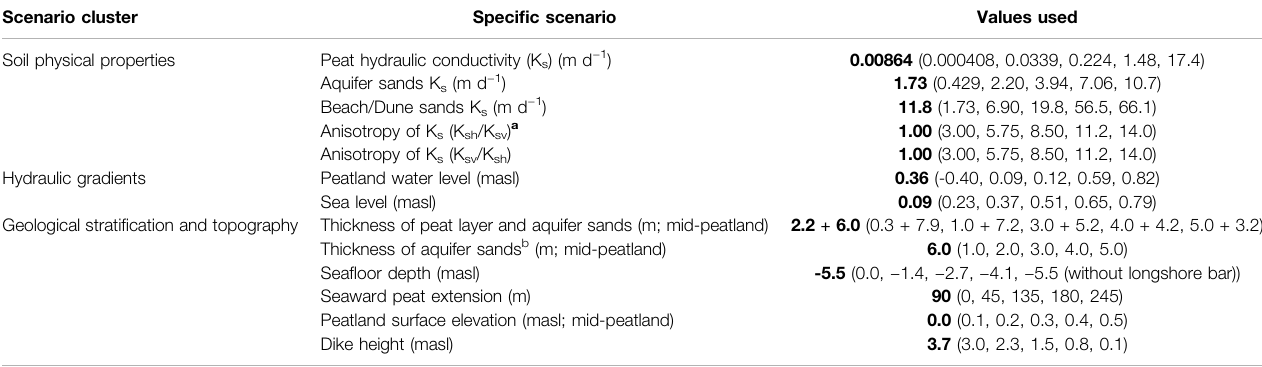
TABLE 2 | Steady-state scenarios used in the modeling. Scenario cluster Speci fi c